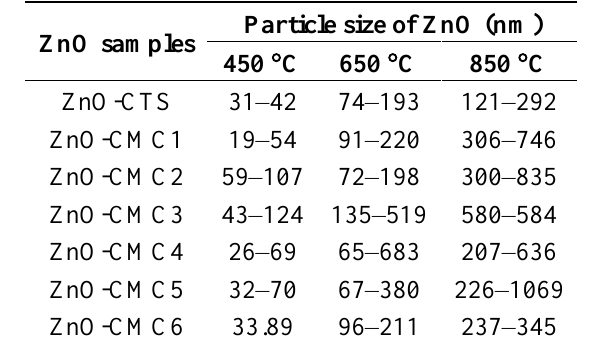
Table 4. Particle size of ZnO prepared at different calcination temperatures of Zn-chitosan polymers.